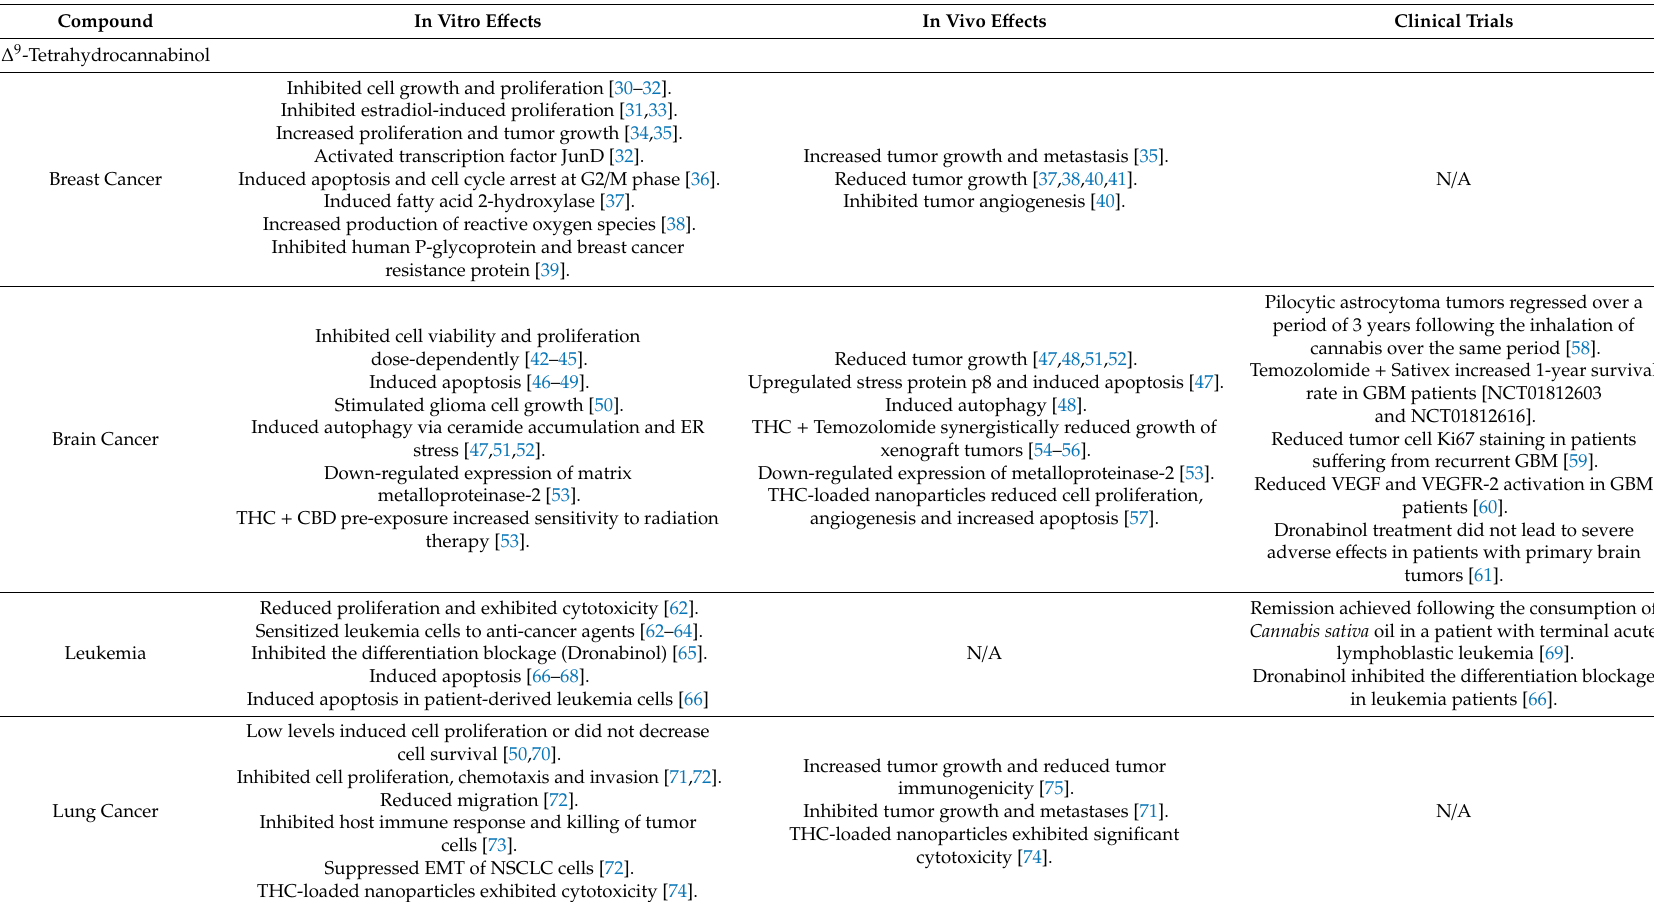
Table 1. Anti-Cancer E ff ects of Cannabinoids Present in